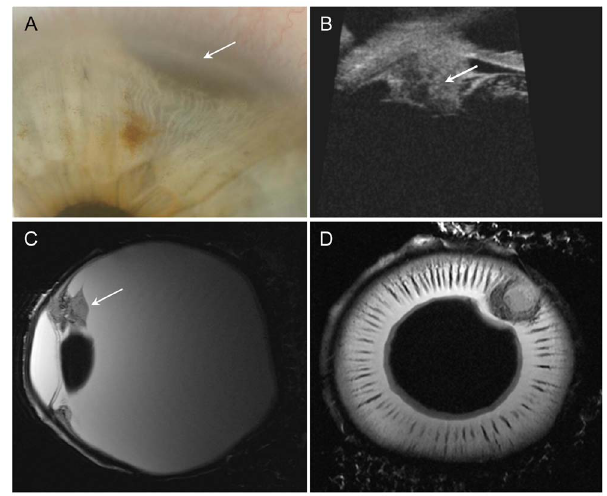
Figure 3. Ciliary body melanoma. A – Photograph: iris with visible melanoma at 1 o’clock (arrow). B – UBM of patient after ruthenium-106 plaque brachytherapy: residual tumor mass with height of 2.7 mm (arrow). C + D – Sagittal and axial T2w images: Inhomogeneous tumor invading the ciliary body (arrow). Low-signal-intensity cap-shaped mass representing the melanin-producing portion of the tumor. No scleral invasion.